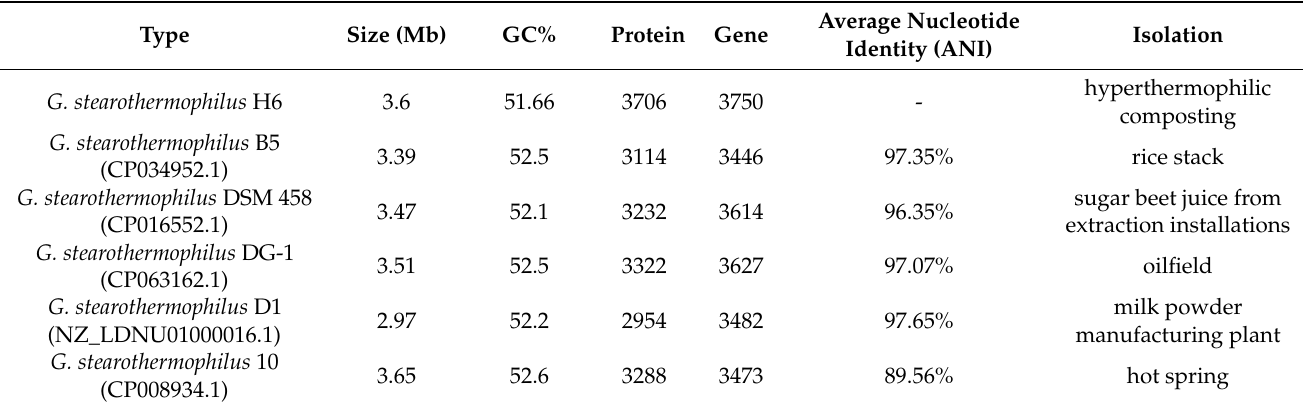
Table 1. Comparison of basic characteristics of whole-genome sequences of strain H6 and other strains of G. stearothermophilus